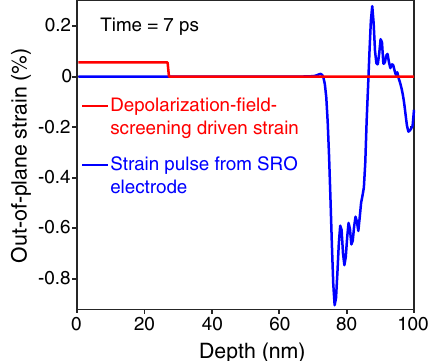
FIG. 7. Simulated acoustic strain profiles produced by depo- larization-field screening (red) and heating of the SRO bottom electrode (blue) as a function of depth at 7 ps after optical